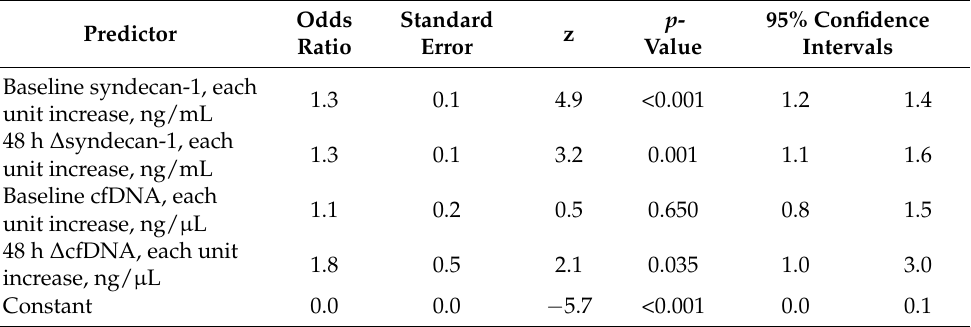
Table 2. Effect of cfDNA and syndecan-1 on 28-day all-cause hospital mortality. Adjusted (multiple) logistic regression table outlining Odds Ratio (OR) of death for each incremental unit increase in baseline and 48 h change (delta, ∆ ) of the plasma cfDNA and syndecan-1 levels.